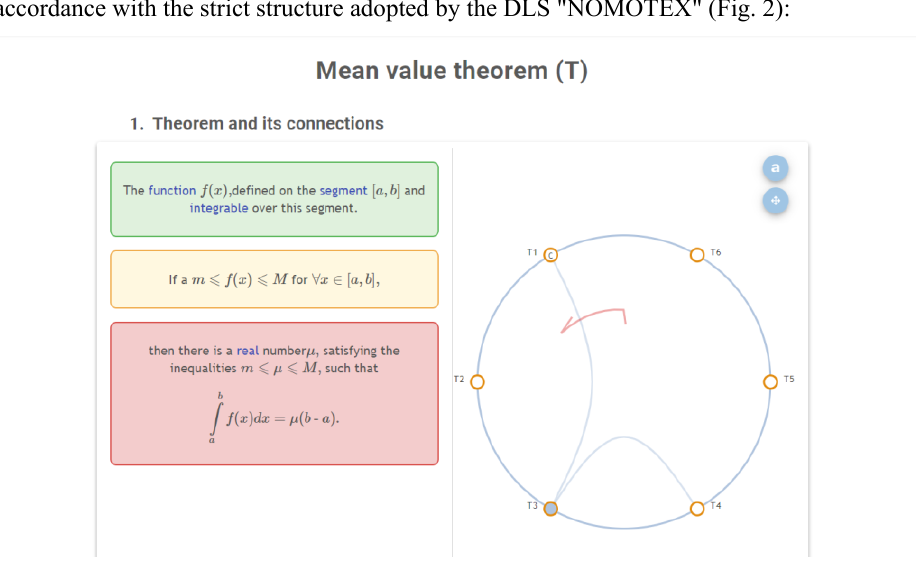
Fig. 2. The structure of statement adopted in the DLS